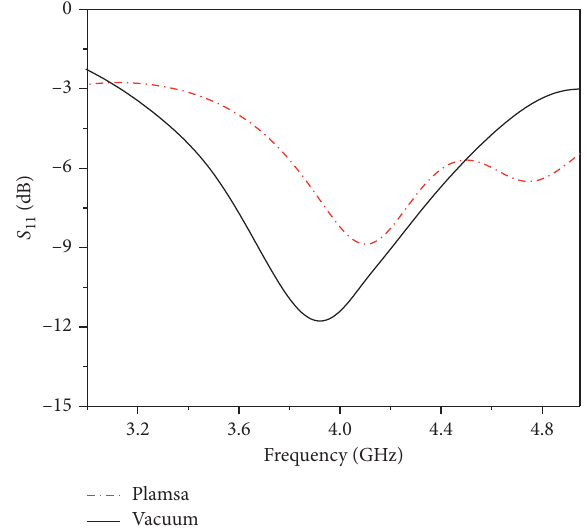
Figure 9: The S 11 versus frequency obtained by CNDS-HO-PML when CFLN � 16 in plasma and vacuum,